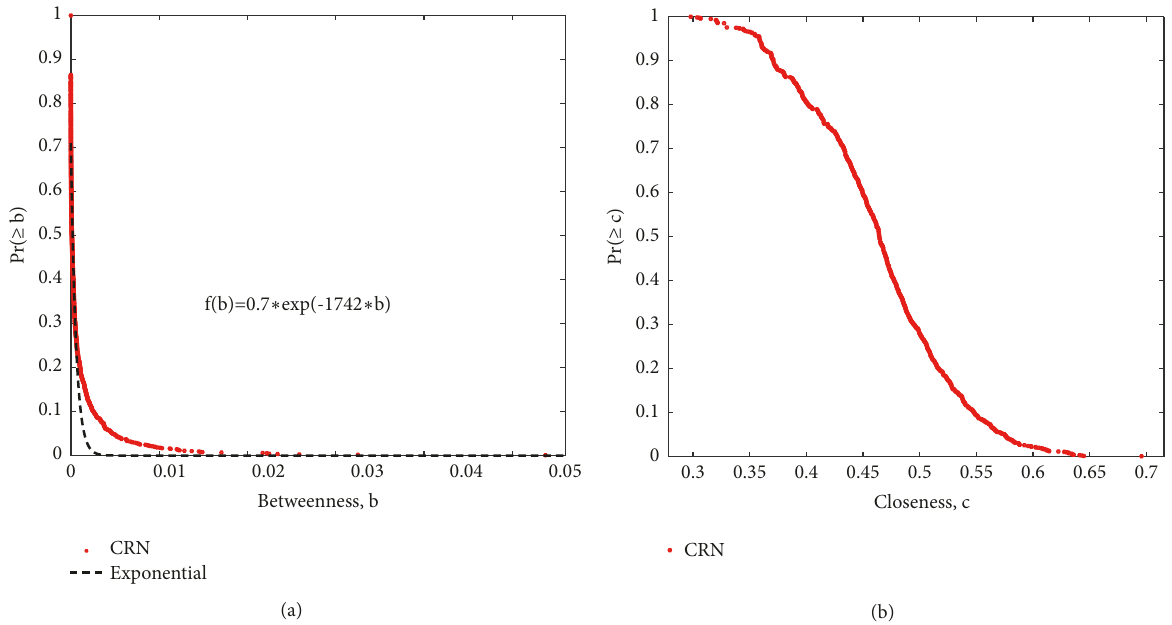
Figure 5: (a) The cumulative distribution of the nodal betweenness in CRN. (b) The cumulative distribution of the nodal closeness in